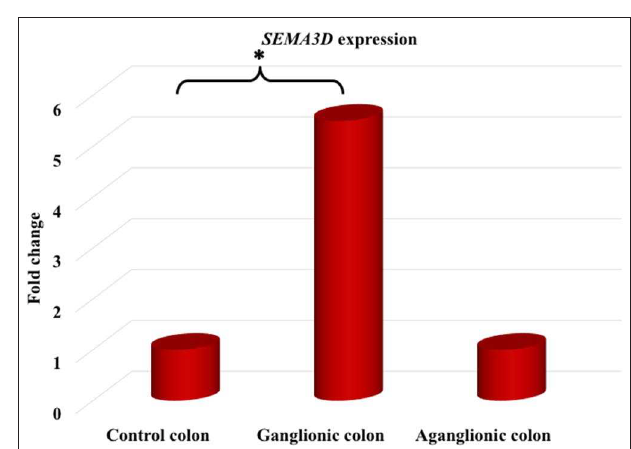
FIGURE 2 | The SEMA3D expression was strongly up-regulated (5.5-fold) in the ganglionic colon of HSCR patients compared to control colon ( p = 0.025), while the SEMA3D expression was not significantly different between the aganglionic colon of HSCR patients and the control colon ( p = 0.89). * p <